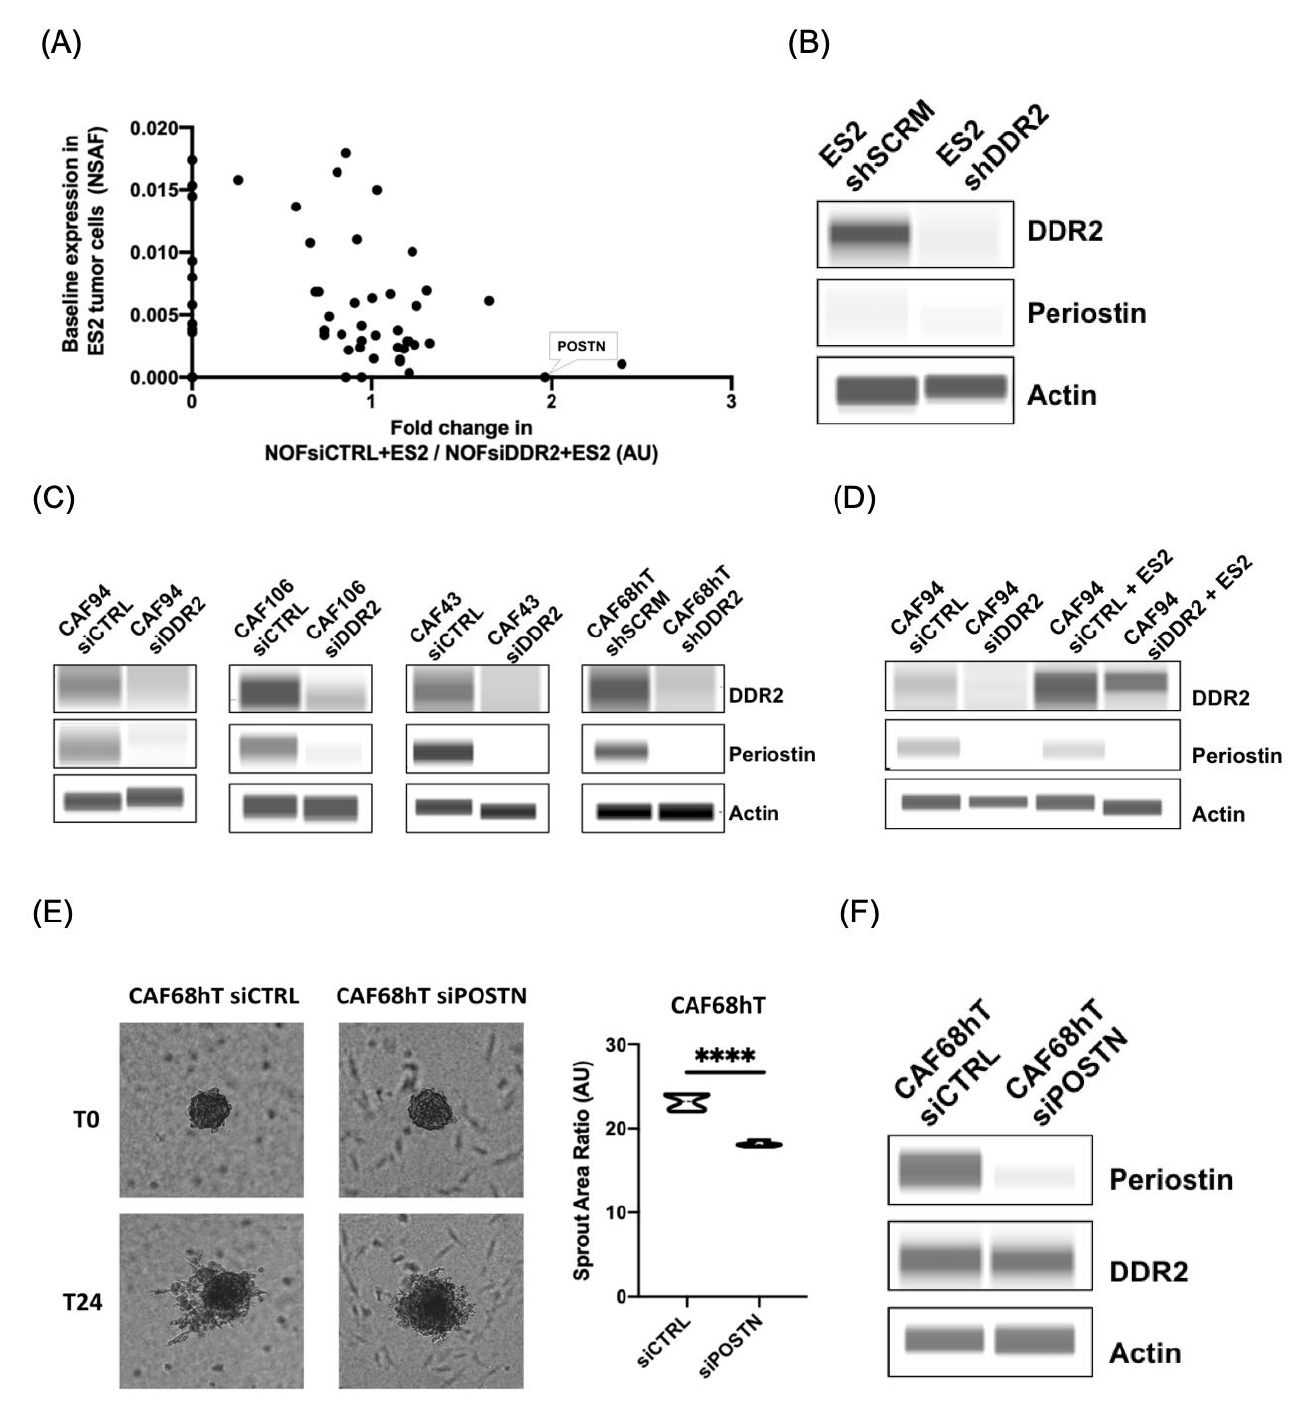
Figure 2. Periostin is decreased in DDR2-depleted fibroblasts co-cultured with tumor cells. ( A ) Mass spectrometry secretome analysis of DDR2-expressing and DDR2-depleted fibroblasts exposed to tumor cells. ( B ) Western blot showing that periostin is not expressed in ES2 tumor cells. ( C ) Western blot validation showing decreased periostin levels in DDR2-depleted CAFs. ( D ) DDR2-dependent decrease in periostin levels is more pronounced when CAFs are co-cultured with tumor cells. ( E ) Decreased tumor spheroid spreading observed upon depletion of POSTN in CAFs and ( F ) Western blot showing POSTN knockdown. **** p < 0.0001.